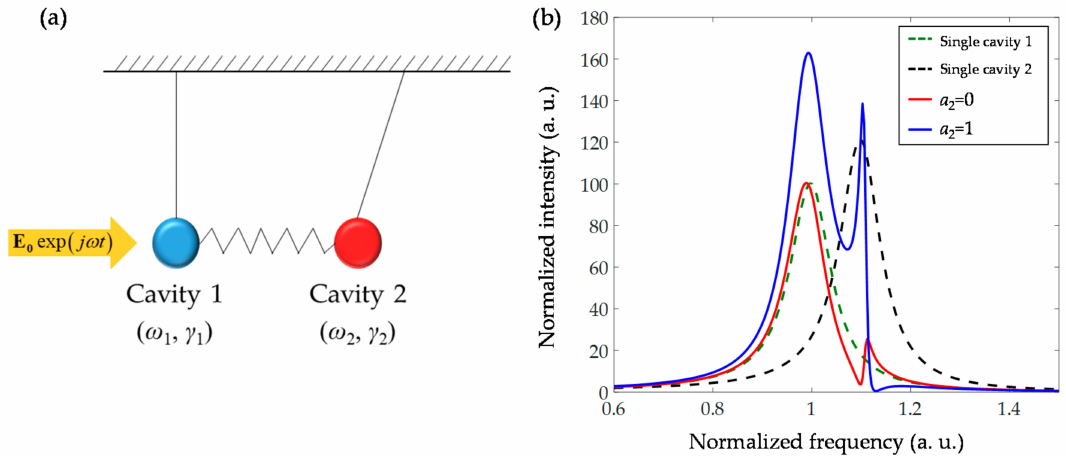
Figure 4. ( a ) Schematic illustration of classical coupled oscillators. Two oscillators are linked with harmonic potential; ( b ) Real values of x 2 in Equation (2) are plotted. Each curve refers to cases when a 2 = 0 (red line) and a 2 = 1 (blue line), respectively. To compare with single oscillator system, Lorentzian line-shapes of single cavity 1 (green dashed line) and 2 (black dashed line) with Q-factor of 10 are plotted, too ( ω 1 = 1, ω 2 = 1.1, γ 1 = 0.1, γ 2 = 0.01, κ =